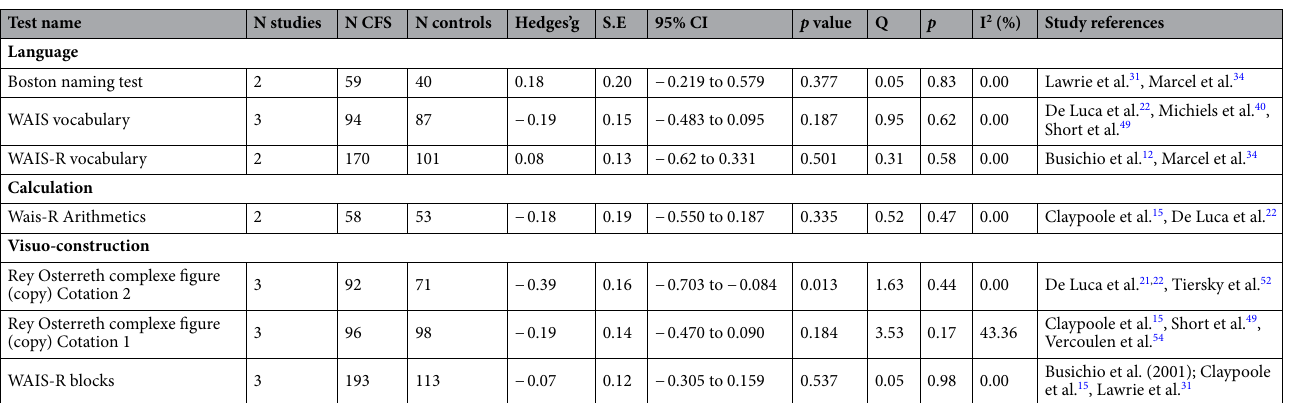
Table 10. Instrumental functions: Hedge’s g effect sizes for each test, in descending order. WAIS Wechsler adult intelligence scale, ME/CFS myalgic encephalomyelitis/chronic fatigue syndrome, N